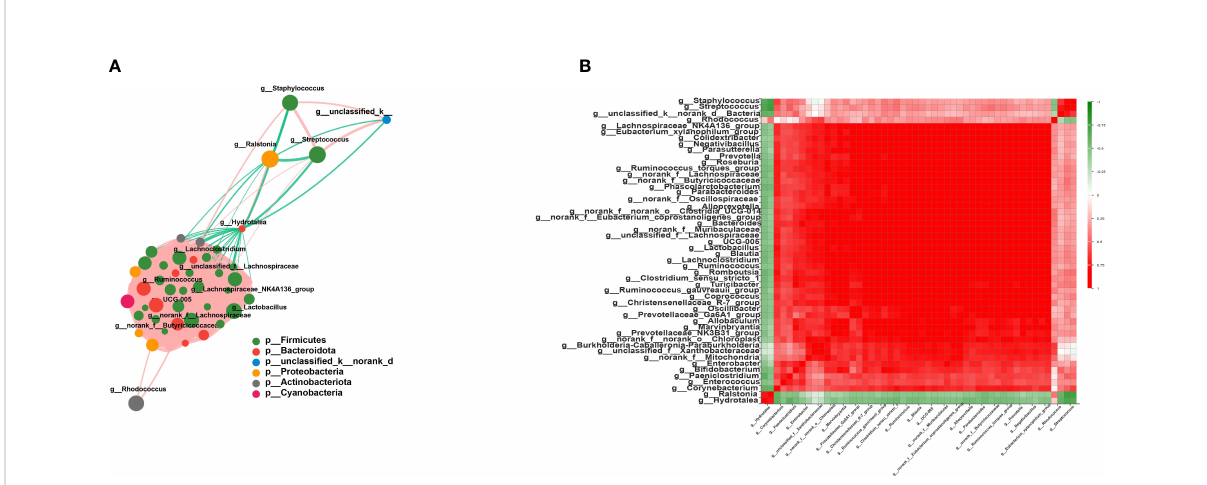
FIGURE 4 Interaction network and correlation analysis. (A) Interaction network of the top 50 species in total abundance. The size of the nodes represents the abundance of species, while different colors represent different species. The color of the connecting lines represents positive and negative correlations: red lines denote positive correlation, while green lines indicate negative correlation. The thickness of the line represents the magnitude of the correlation coef fi cient. (B) Correlation coef fi cient heatmap. Both the x - and y -axes indicate the species, with red denoting positive correlation and green indicating negative